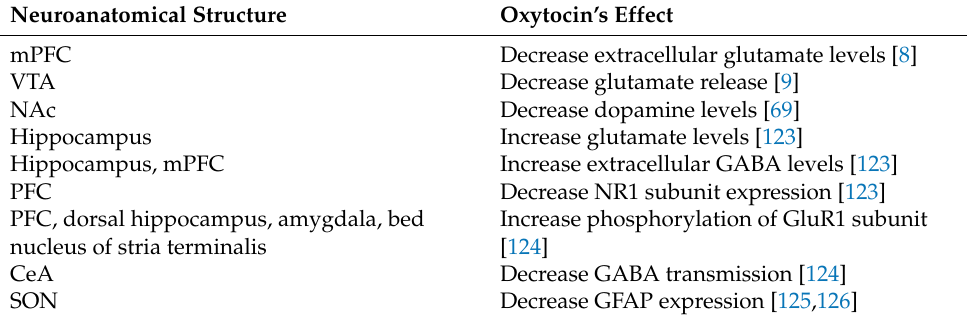
Table 1. Oxytocin’s effects on drug-induced molecular changes based on structure. VTA = ventral tegmental area; NAc = nucleus accumbens; mPFC = medial prefrontal cortex; PFC = prefrontal cortex; CeA = central amygdala; SON = supraoptic nuclei; GABA = γ -aminobutyric acid; GFAP = glial fibrillary acidic